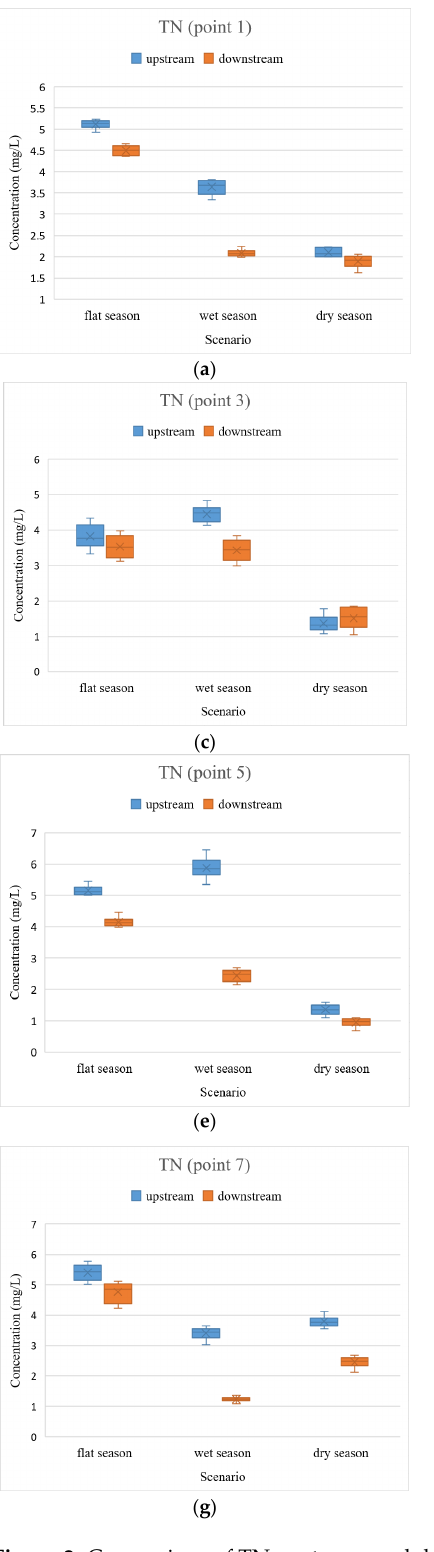
Figure 2. Comparison of TN upstream and downstream of the rivers in the closed state of the sluices. ( a ) TN concentrations at point 1; ( b ) TN concentrations at point 2; ( c ) TN concentrations at point 3; ( d ) TN concentrations at point 4; ( e ) TN concentrations at point 5; ( f ) TN concentrations at point 6; ( g ) TN concentrations at point 7; ( h ) TN concentrations at point 8.